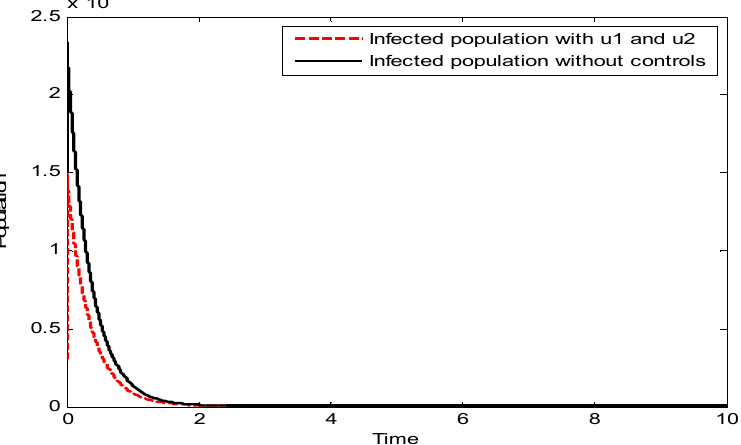
Figure 6. Comparing the dynamics of the infected population without control and with control 𝑢 (cid:2869) &𝑢 (cid:2870) .